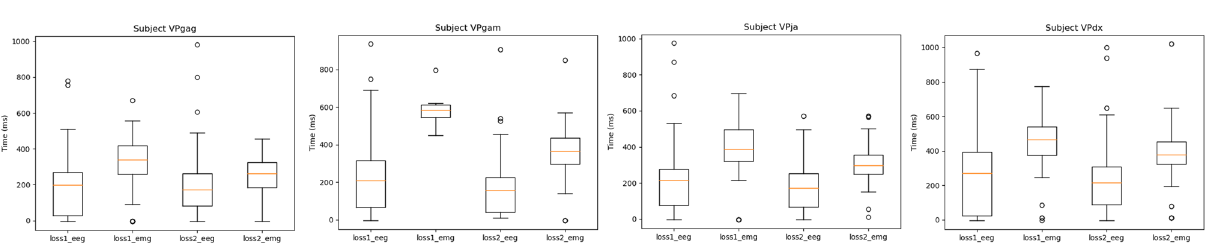
Figure 5. An illustration of reconstruction (loss1) and prediction (loss2) loss corresponding to stimulus/ emergency (locate at time 340 ms), which is marked as a pink vertical line.